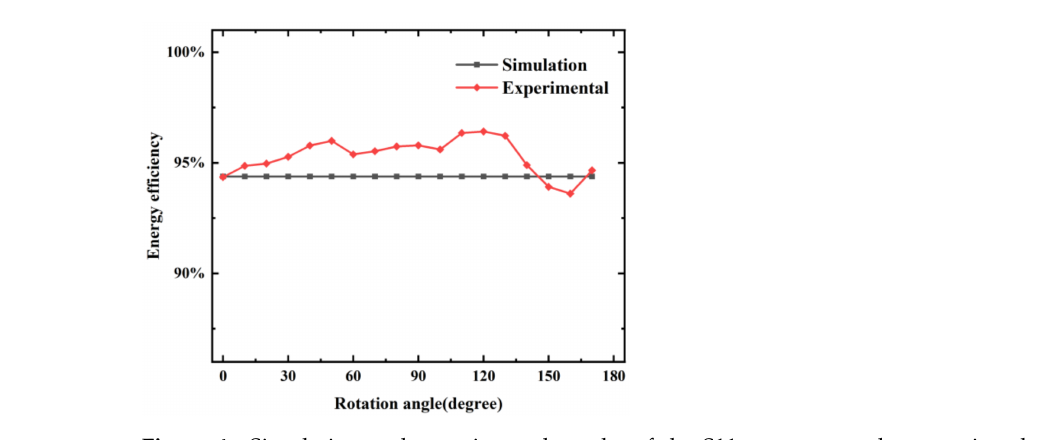
Figure 4. Simulation and experimental results of the S11 parameter when rotating the coaxial slot radiator.